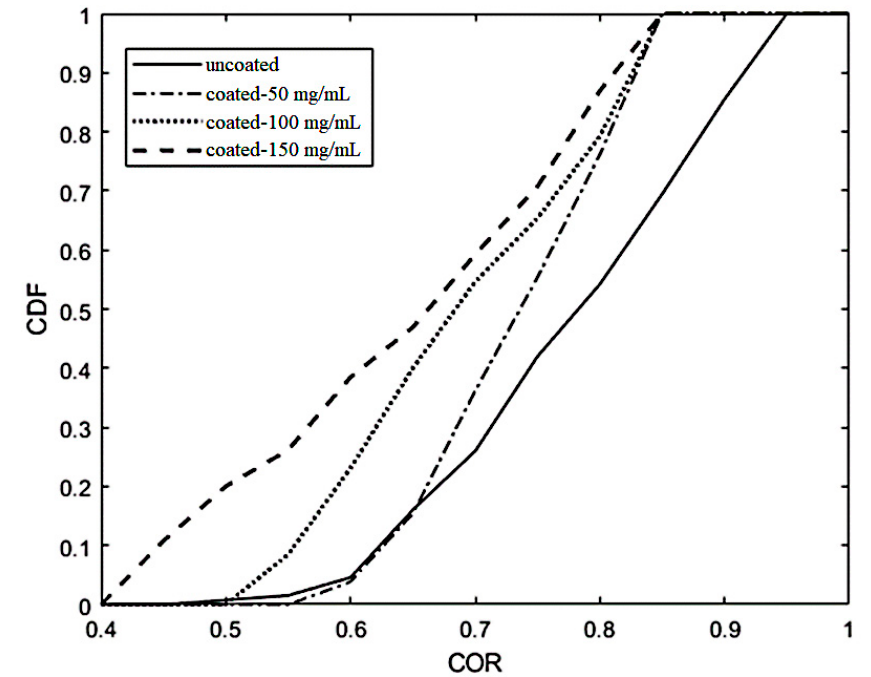
Figure 10. CDF of COR values for different coated LBS colliding with granite block at the impact velocity of 2.42 m/s. velocity of 2.42